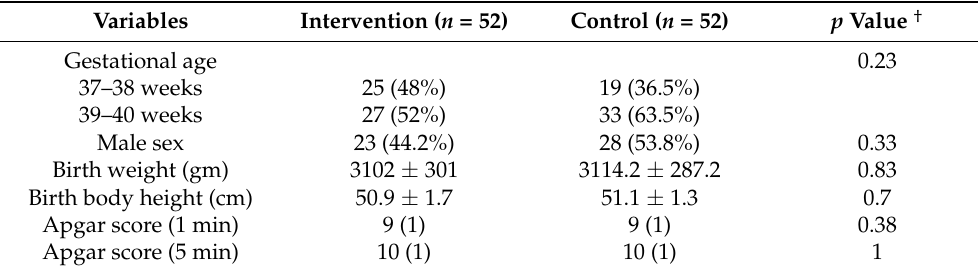
Table 2. Demographic characteristics of